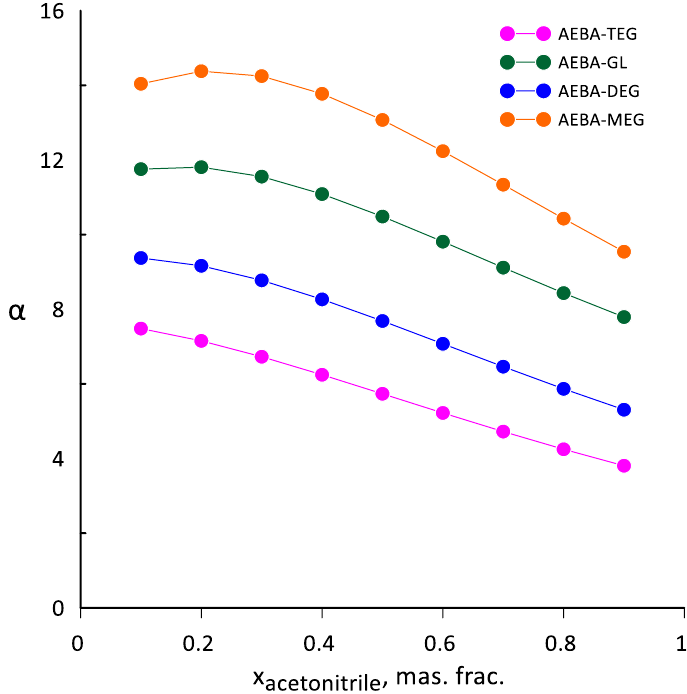
Figure 9. Relative volatility of acetonitrile in an azeotropic mixture of acetonitrile–water with the addition of 60 wt.%